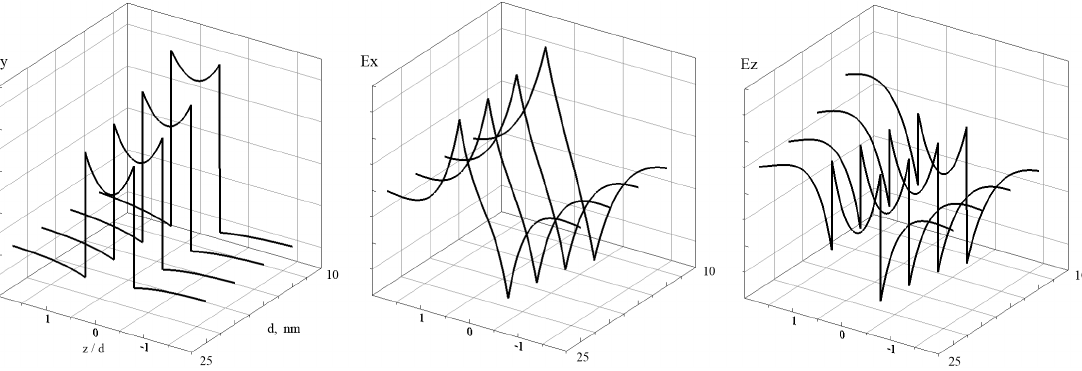
Figure 3. Distribution of the wave-field components of the TM wave; f = 20 THz, µ = 0.10 eV, ε 2 = 10, d = 10;14;18;20 mm.